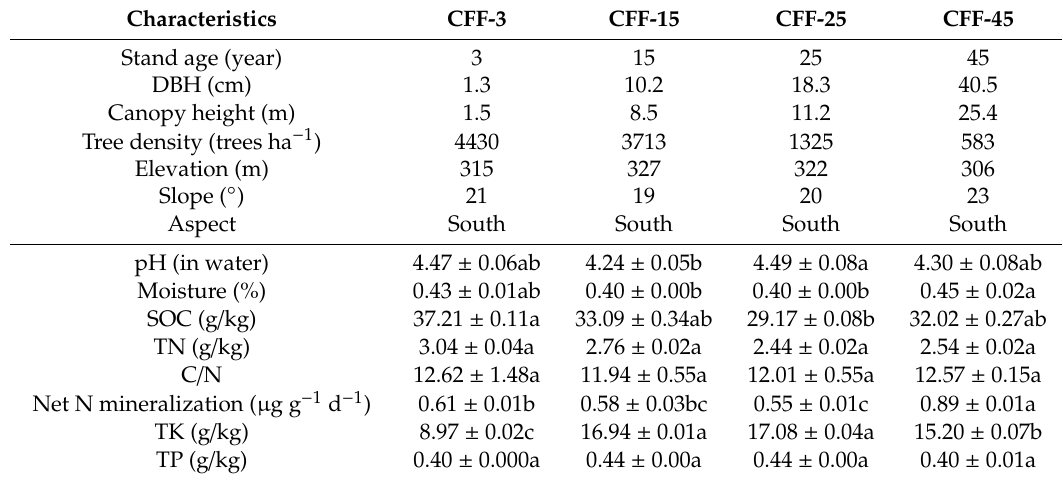
Table 1. Stand and soil characteristics of Chinese fir plantations with varying ages in Jiangxi Province.